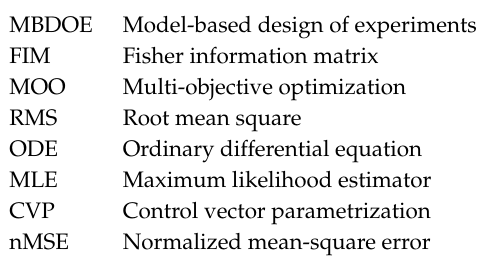
Figure S1: Pareto frontier of the MOO MBDOE using curvatures and a FIM-based criterion. Figure S2: Pareto frontier of the MOO MBDOE using correlation and a FIM-based